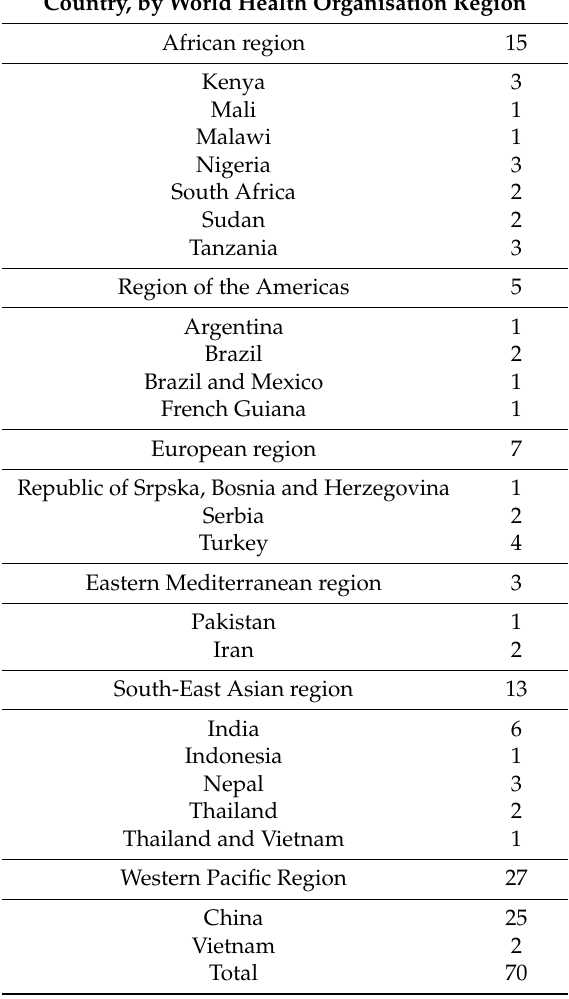
Table 3. Country